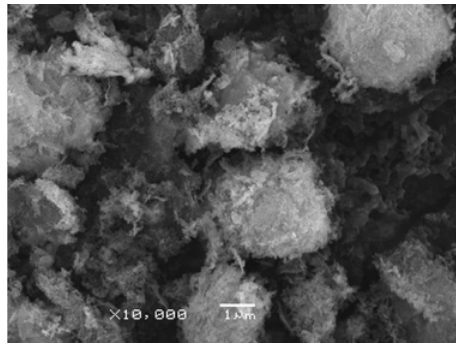
Figure 1: Morphology of MgO powder.